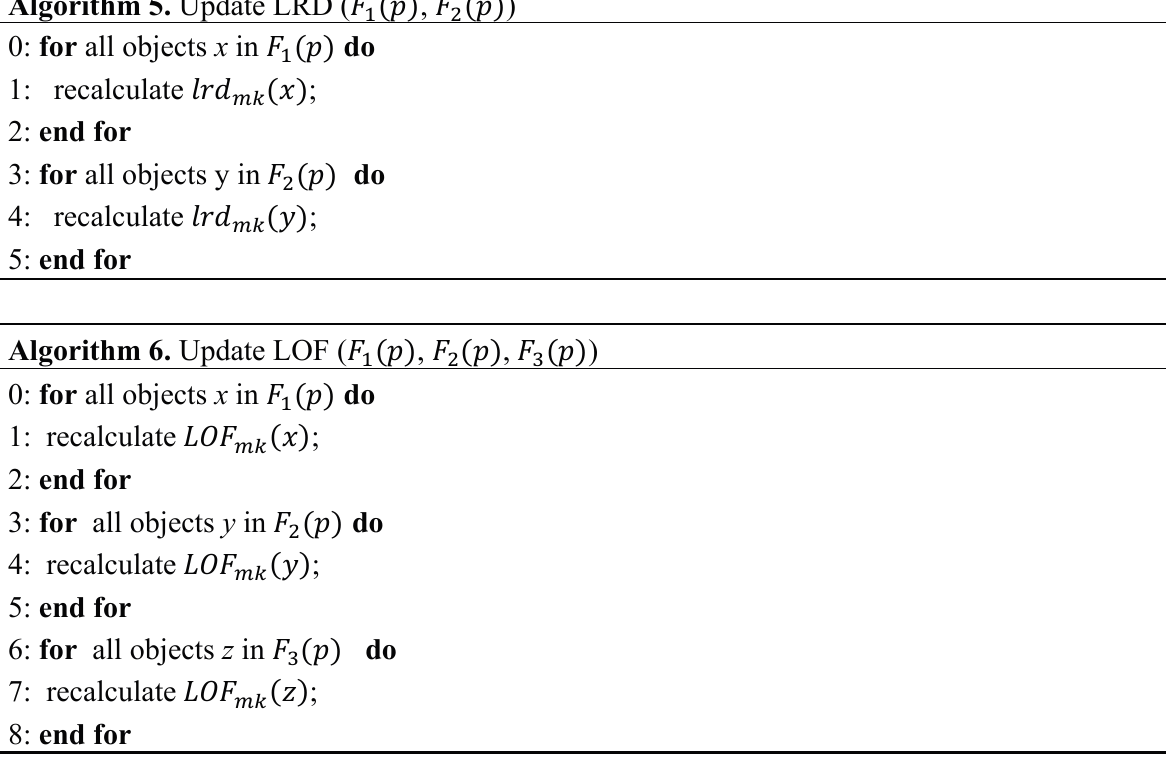
Algorithm 5. Update LRD ( (cid:1832)